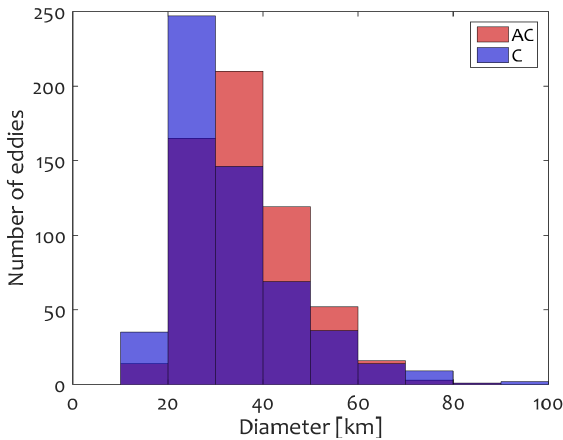
Figure 13. Absolute counts of eddy diameters for AC and C eddies detected in the SST imagery of the Liguro-Provençal